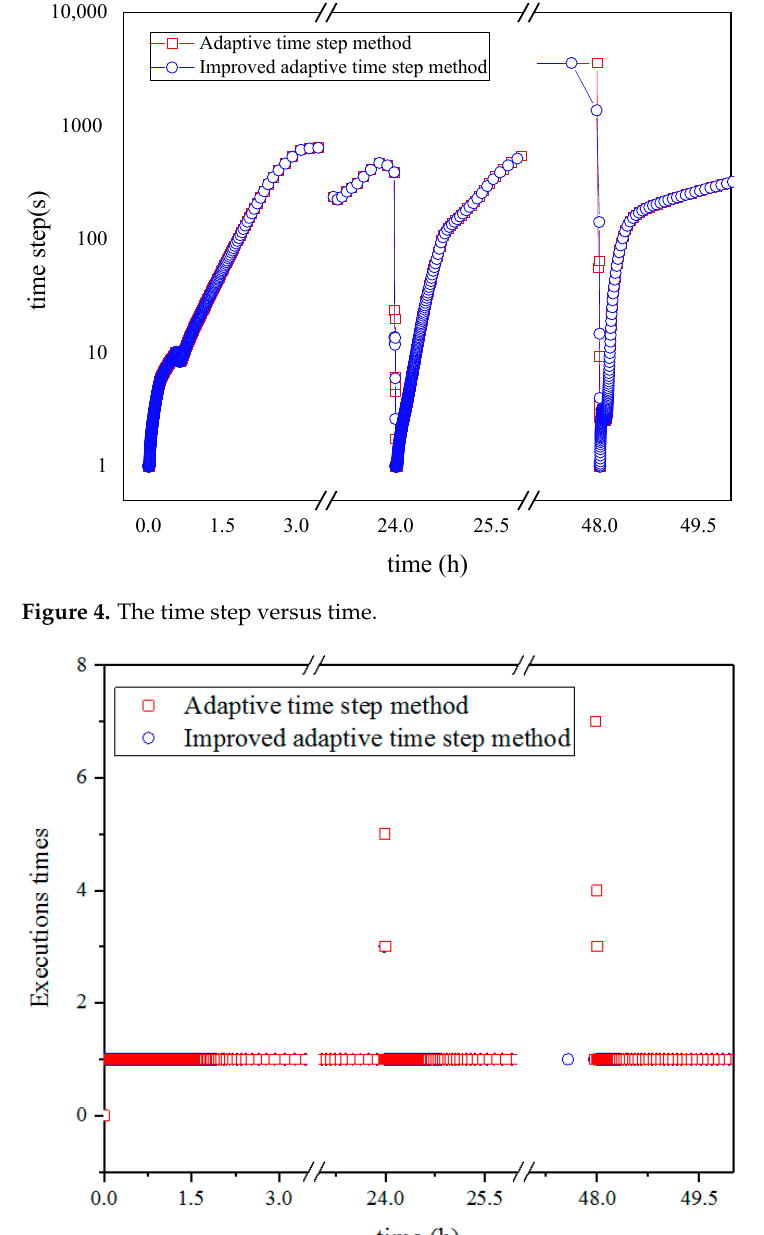
Figure 5. The execution times versus time.